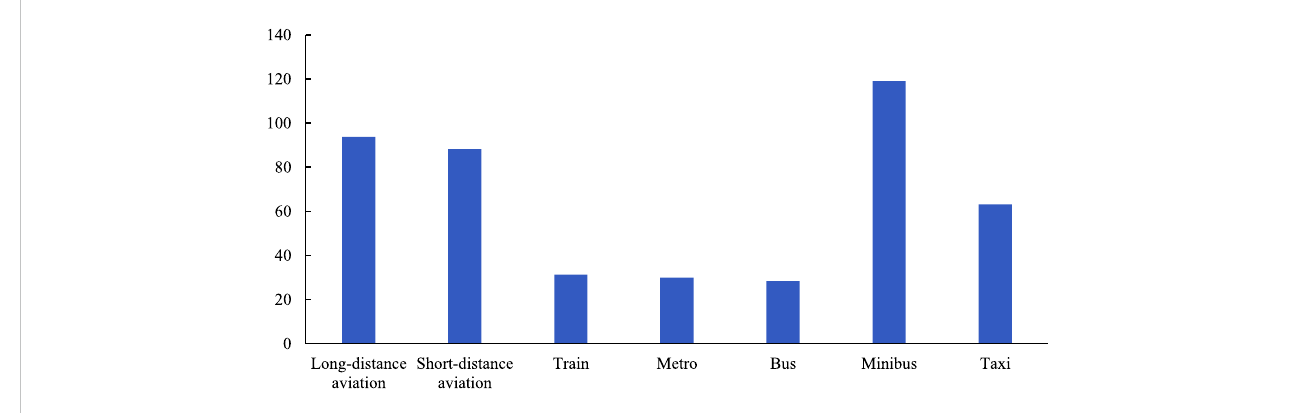
FIGURE 2 Carbon dioxide emissions of different vehicles driving 1,000 km (unit: kg).